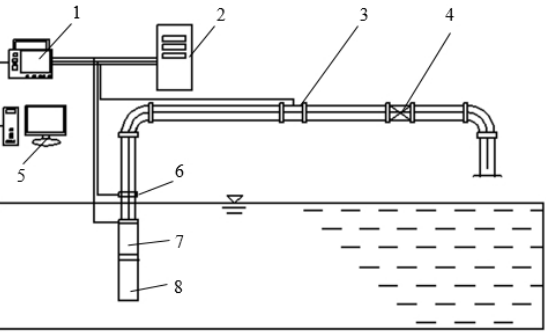
Figure 6. Testing apparatus. 1. Data acquisition instrument. 2. Frequency inverter. 3. Electromagnetic flowmeter. 4. The valve. 5. Computer. 6. Pressure sensor. 7. Pump. 8. Motor.